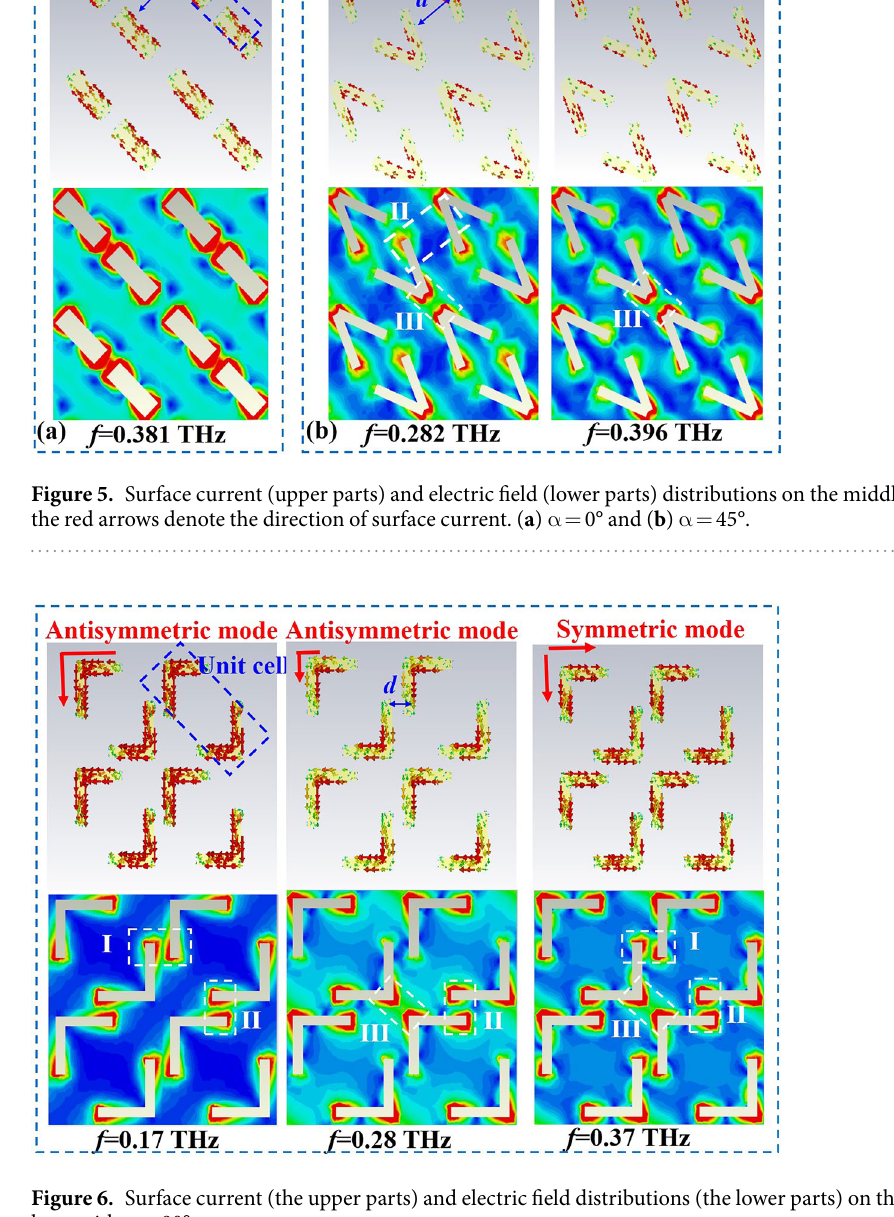
Figure 6. Surface current (the upper parts) and electric field distributions (the lower parts) on the metasurface layer with α =